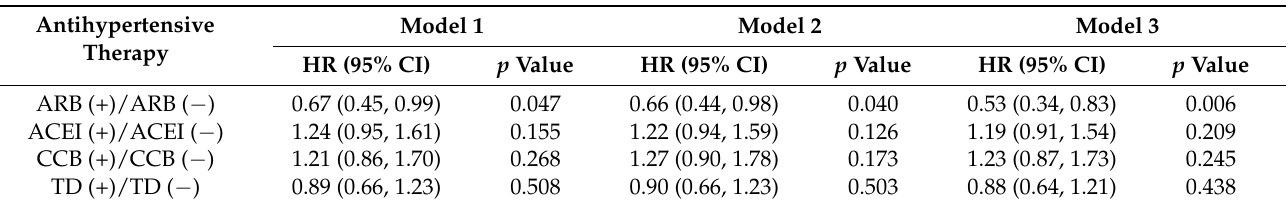
Table 2. Risks of primary outcomes for patients on different antihypertensive therapies compared to those without.